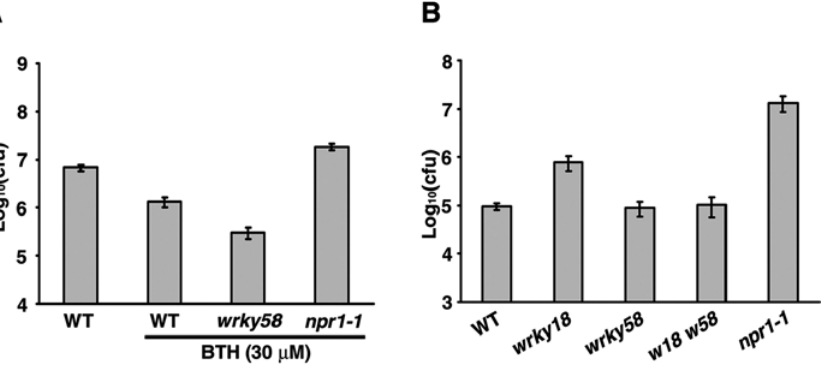
Figure 5. Resistance Defects of wrky58 (A) Loss of WRKY58 confers resistance when plants were weakly induced with 30 mM BTH. (B) To examine the function of WRKY58, the wrky58 mutation was introduced into wrky18, and the effect was observed in an EDS test 3 dpi. w18 w58 represents the wrky18 wrky58 double mutant. Both (A) and (B) were performed twice with similar